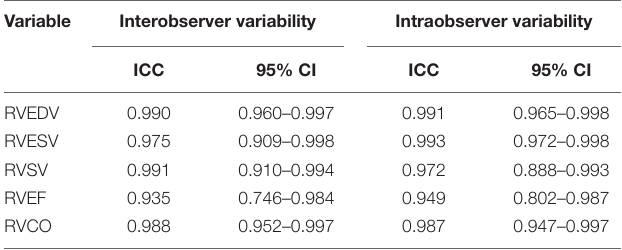
TABLE 6 | ICCs for intra- and interobserver variability for 3DE RV measurements. Variable Interobserver variability Intraobserver